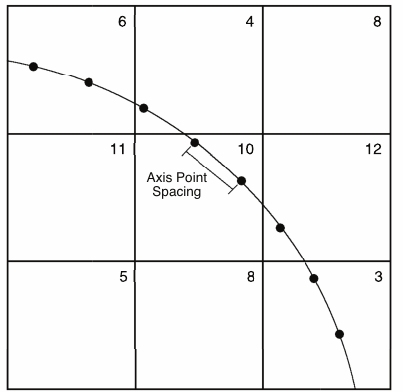
Figure 1. Illustration for computing the mean pixel value on a given spiral axis with a given pitch. The squares represent pixels on a galaxy image, and the numbers are the pixel values. The solid curve represents one spiral axis; the dots are the sampling points. The AxisPointSpacing input parameter is the distance, in pixels, between sampling points. The mean pixel value is the mean of all the pixels cut by the spiral, weighted by the number of sampling points in each pixel. For the spiral axis segment shown in this figure, the mean pixel value is ( 2 ∗ 6 + 4 + 2 ∗ 10 + 12 + 2 ∗ 3 ) /8 = 6.75. The variance of these means, computed over all spiral axes for a given pitch angle, yields the fitting function for that pitch. When the axis pitch most closely matches the galaxy’s pitch, the fitting function is